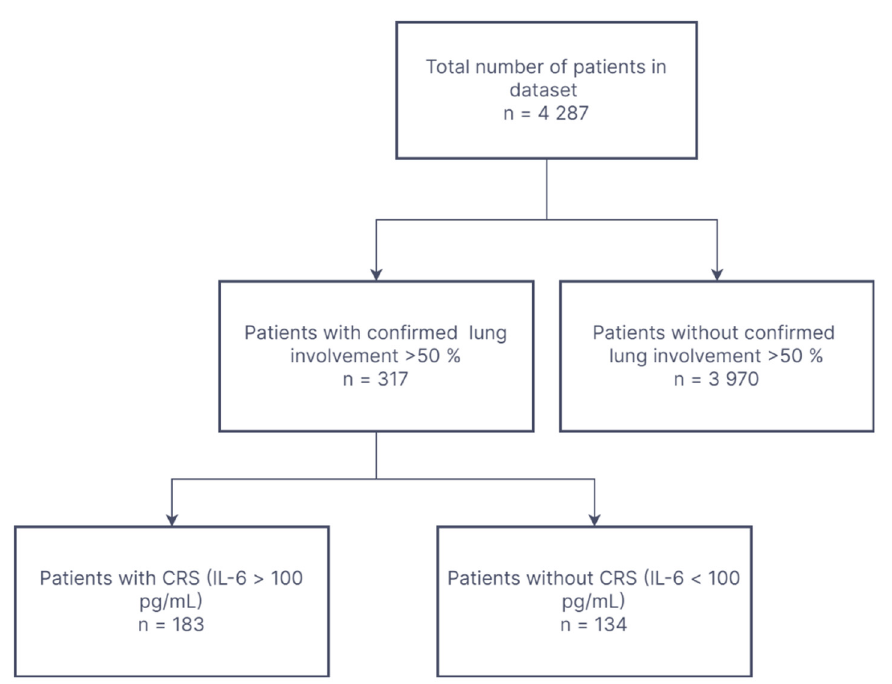
Figure 1. Flowchart of the study inclusion criteria. Table 1. Baseline characteristics of all patients included in the